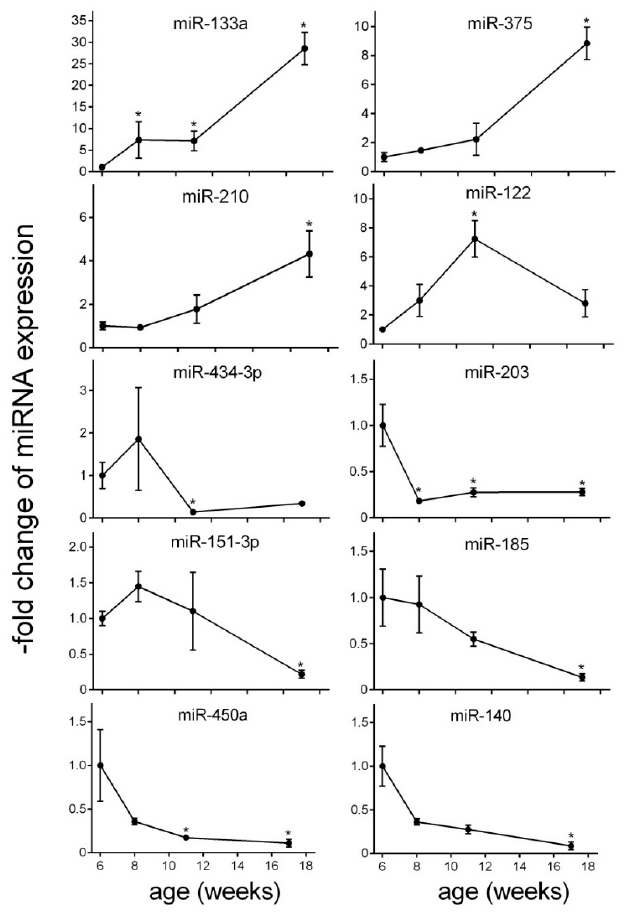
Figure 5. Significantly-altered miRNAs during disease progression. Relative expression is given as the fold increase to baseline (PD). Significant differences to baseline are indicated by * ( p < 0.05). Values represent the mean ± SEM.